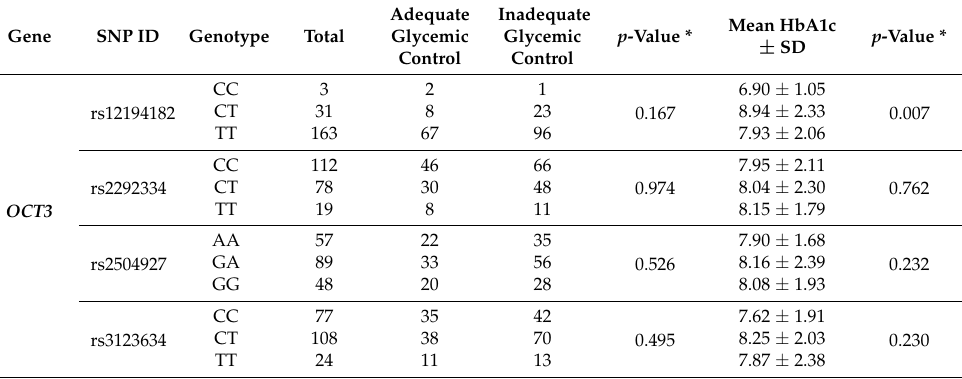
Table 6. Effect of genotype distribution of studied SNPs for OCT3 gene on glycemic control and on HbA1c level in Jordanian T2DM patients receiving metformin.